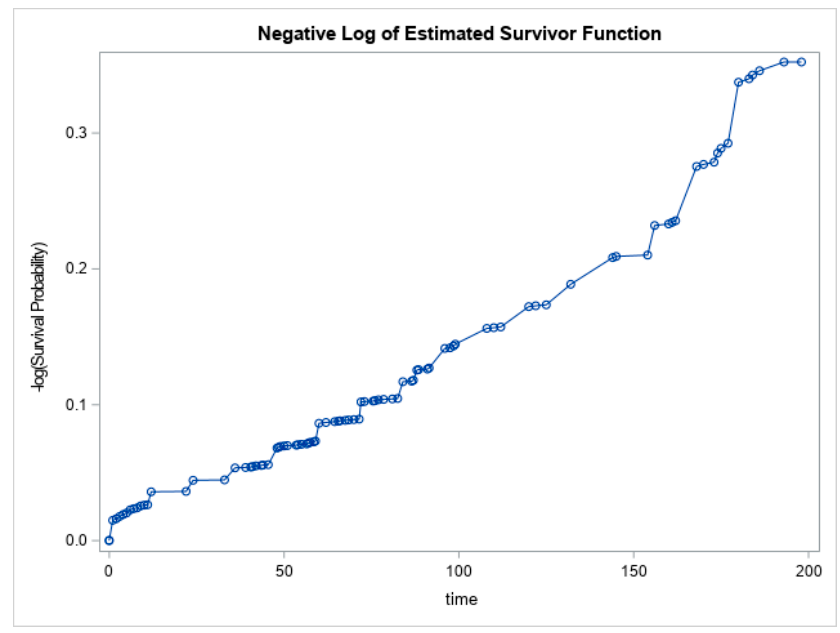
Figure 2. Nonparametric hazard function of paresthesia-free survival ( n = 3,411).